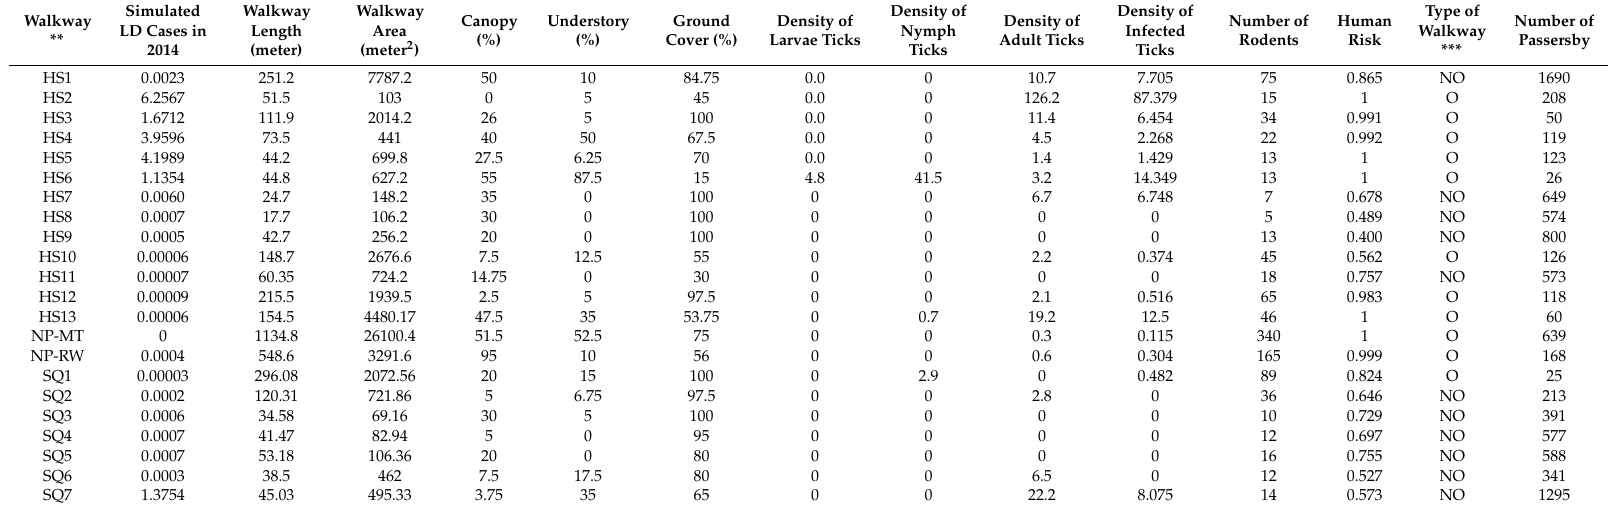
Table 1. Simulated Lyme cases in 2014, walkways length and area, vegetation, tick density per 1000 m 2 , number of rodents, percentage of humans at risk, type of walkway, and average number of passersby per day by walkway for 22 high-use walkways on the Binghamton University Campus *. LD: Lyme disease. Walkway